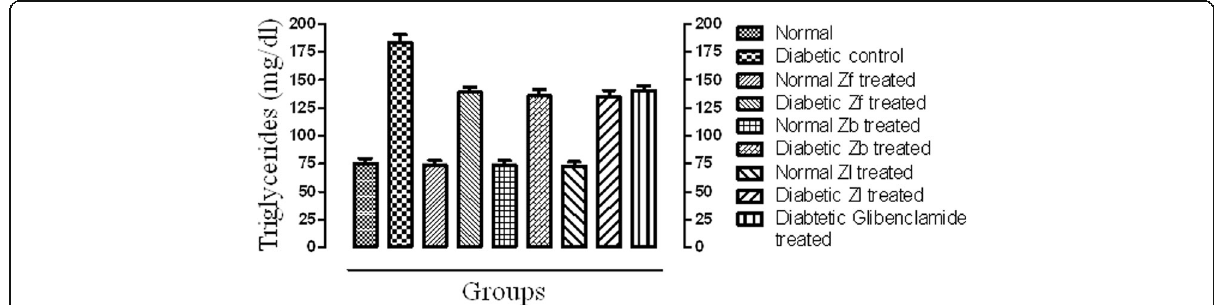
Fig. 2 Effect of extracts and standard drug on serum triglycerides (mg/dl) level of normal and alloxan monohydrate induced diabetic mice